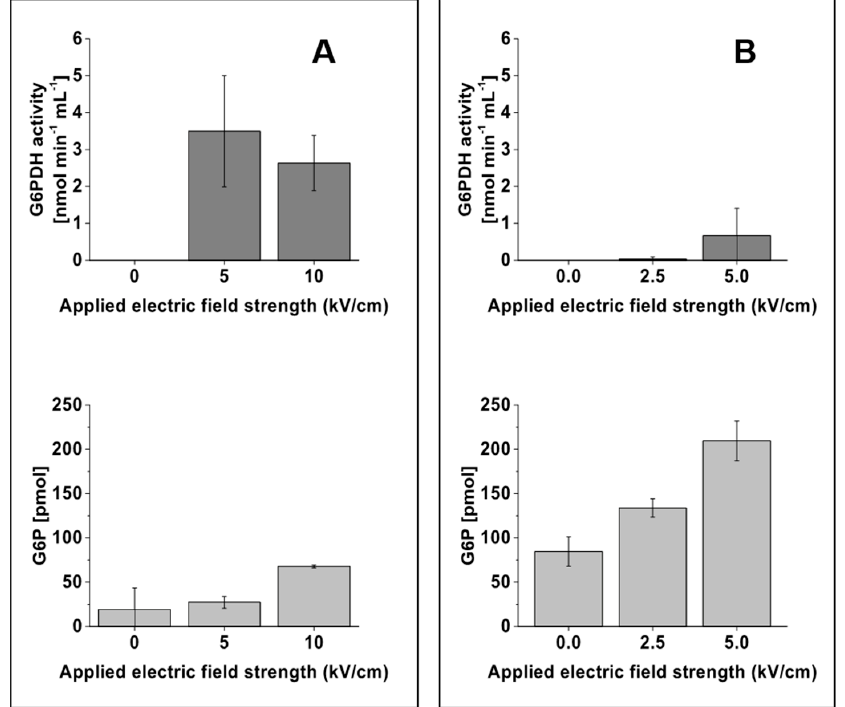
Figure 3. Influence of different electric field strengths on the activity of the enzyme glucose-6-phosphate dehydrogenase (G6PDH) and the amount of glucose-6-phosphate (G6P) from E. coli (( A ), left column) and S. cerevisiae (( B ), right column). The dark and light grey colored bar charts denote, respectively, the activity of the enzyme G6PDH and the amount of G6P at the given electric field strengths. The data were obtained from three biological replicate experiments performed with three di ff erent microfluidic chips. The error bar represents the standard deviation calculated from the biological